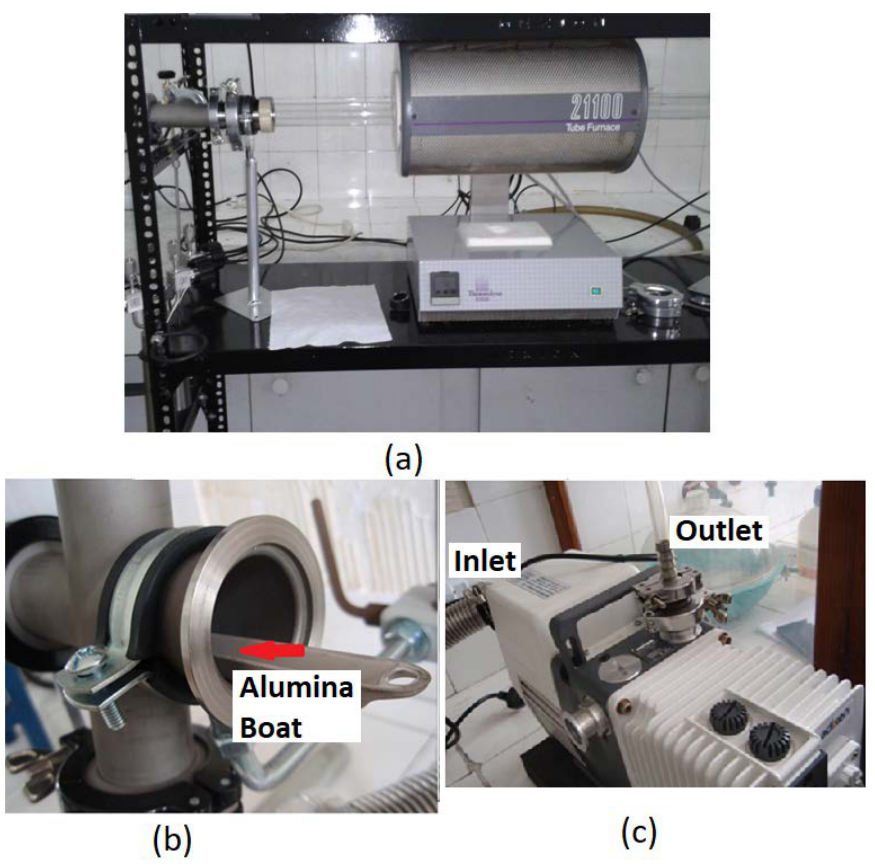
Figure A1. ( a ) CVD chamber used for CNT growth, ( b ) alumina boat where substrates are placed, and ( c ) vacuum pump used to evacuate the chamber.